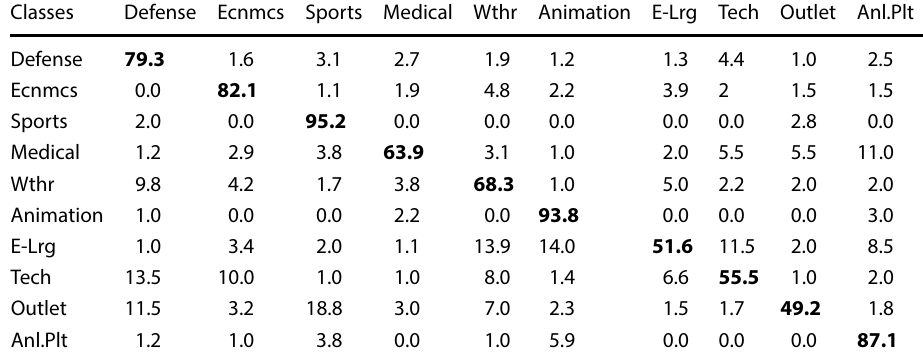
Bold indicates the best